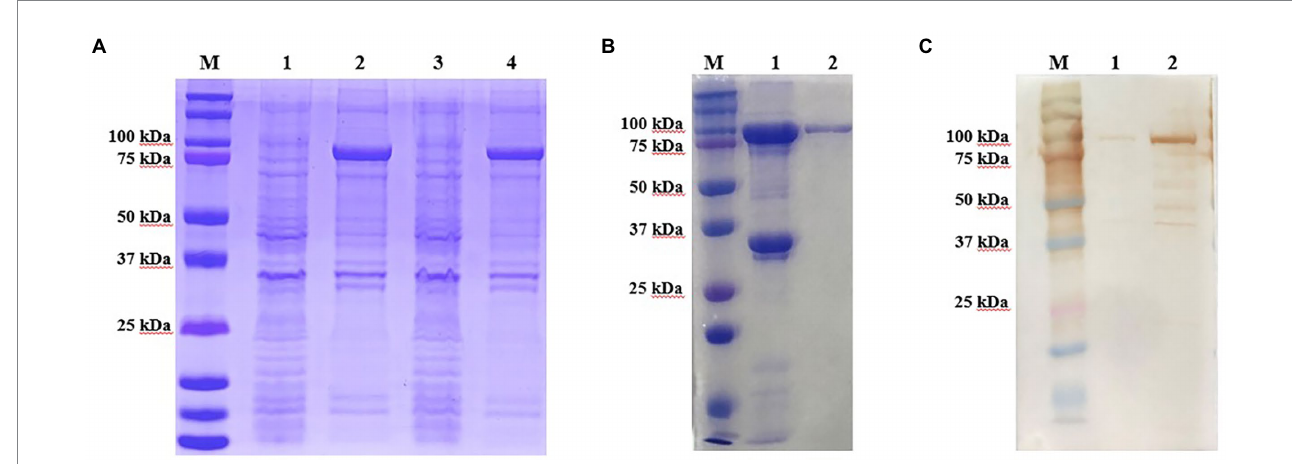
FIGURE 2 Production and identification of the p72 recombinant protein. (A) Expressed form of p72 recombinant protein in E. coli . M is the protein marker, lane 1 contains the bacterial lysate before induction, lane 2 contains the bacterial lysate after induction, lane 3 contains the supernatant after ultrasonic lysis of the bacteria, and lane 4 contains the precipitate after ultrasonic lysis of the bacteria. (B) Purification of the p72 recombinant protein. M is the protein marker, lane 1 contains the cell precipitate before purification, and lane 2 contains the purified p72 recombinant protein. (C) Reactivity of p72 recombinant protein with ASF-positive serum. M is the protein marker, lane 1 contains the pre-induction bacterial lysate, and lane 2 contains the post-induction bacterial lysate.